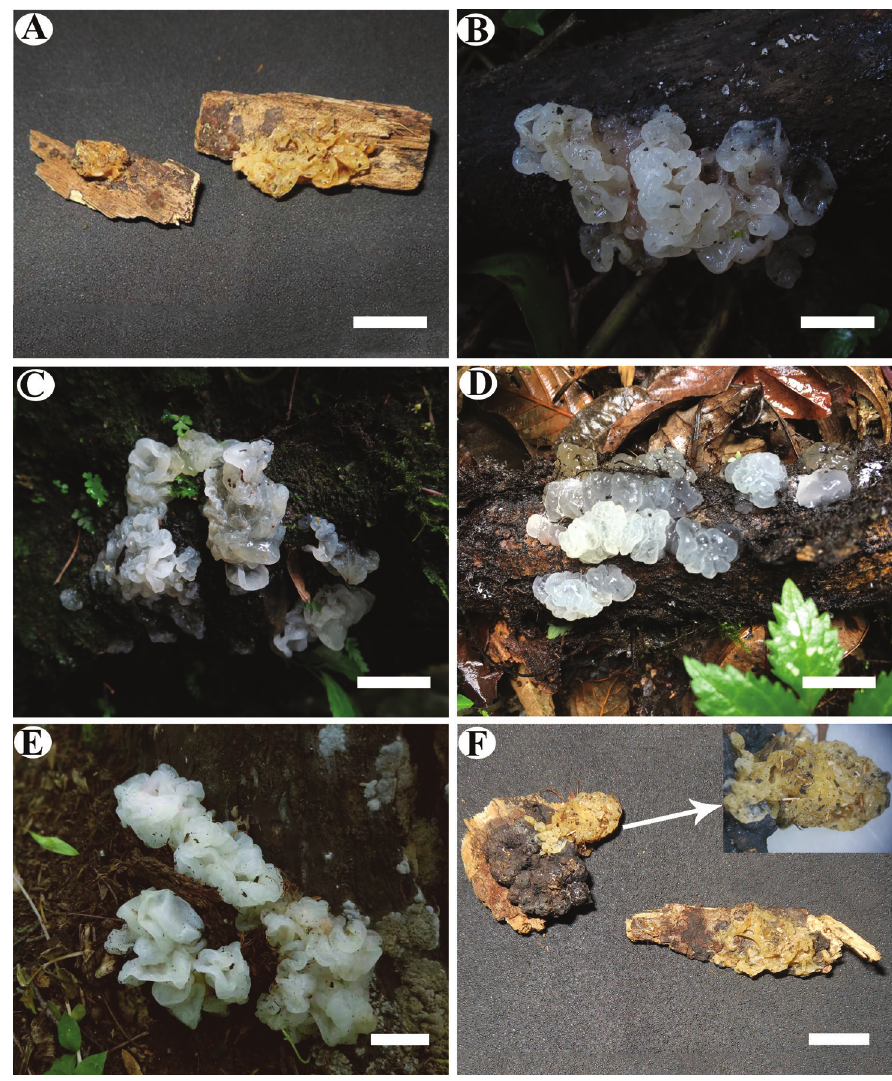
Figure 3. Basidioma A Tremella fibulifera (Alvarenga 471) B T. australe (Wu 154) C T. guangxiensis (Wu 3) D T. latispora (Dai 17568) E T. “neofibulifera” (Wu 244) F T. subfibulifera (Alvarenga 334). Scale bars: 1 cm ( A–F ). Etymology. Refers to the distribution of this species in South Asia. Basidioma. Sessile, when fresh soft gelatinous, creamy-white to beige, translucent, cerebriform, with thick and undulate lobes, up to 4.0 cm long, 2.0 cm broad and 2.0 cm high from base, distinctly shrinking into a film and becoming pale yellow when dry, broadly attached to substratum. 6.0 µm in diameter, branched, interwoven, with abundant clamp connections,